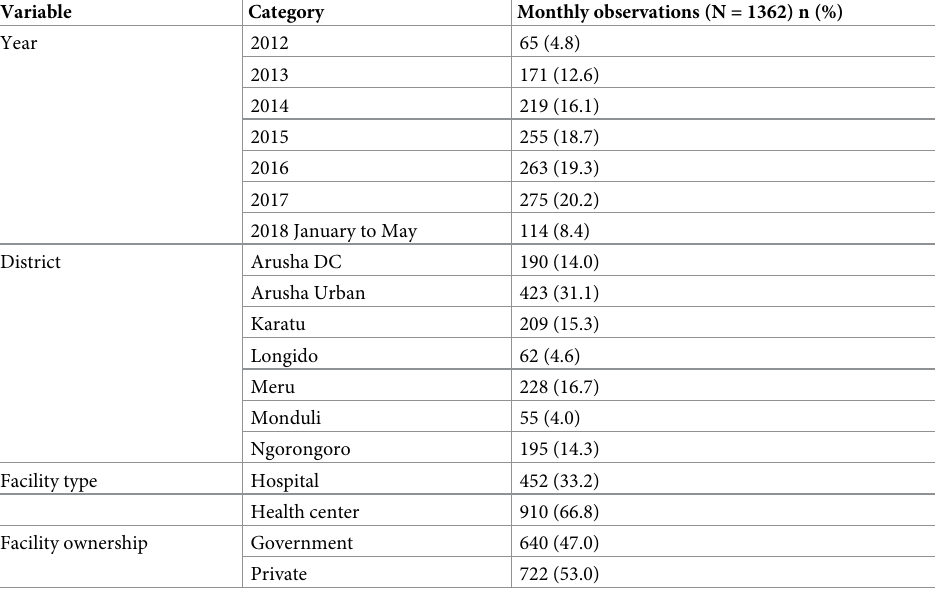
Table 5. Characteristics of monthly level data from 24 health facilities over all months of observation (n = 1362 months of observation).